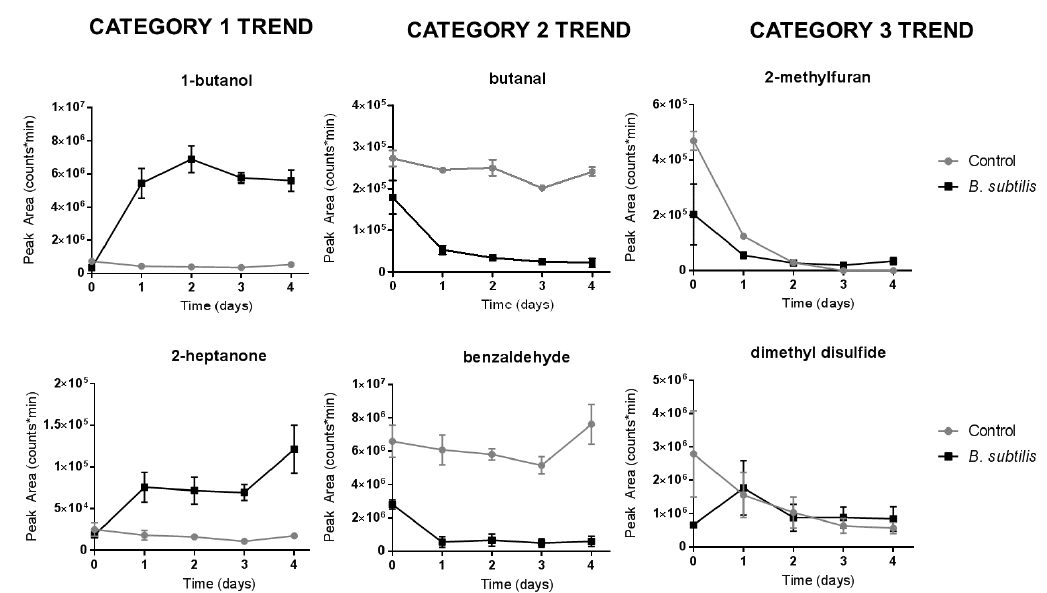
Figure 4. Example volatile organic compounds (VOCs) detected from Bacillus subtilis in each of the three categories of compound production. Category 1 compounds (‘produced VOCs’) were higher in bacterial samples than in control samples. Category 2 compounds (‘consumed VOCs’) were higher in control samples than in bacterial samples. Category 3 compounds (‘equilibrated VOCs’) in bacterial samples eventually equilibrated with control samples early in the longitudinal data and did not exhibit a significant difference to the controls over time. Compound trends for all 25 compounds of interest are shown in the Supplementary Material, Figures S1–S3.